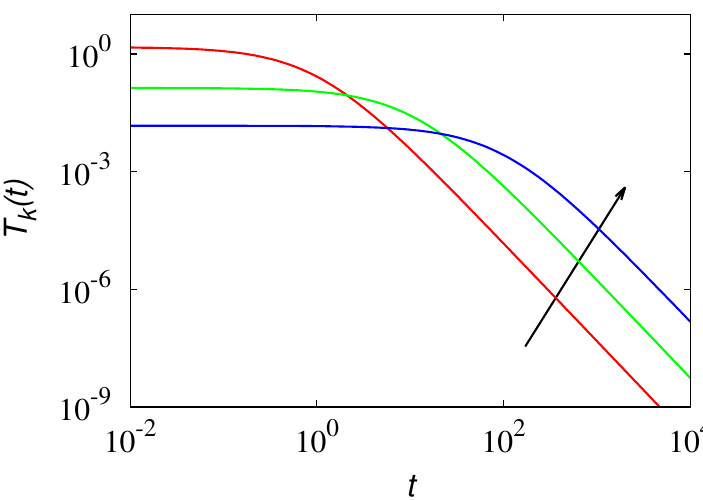
Figure 2. Transition functions T k ( t ) , Equation (25), for the generalized counting process defined by Equations (17) and (29) with ξ = 1.5, τ c = 10. The arrow indicates increasing values of k = 1,2,10.